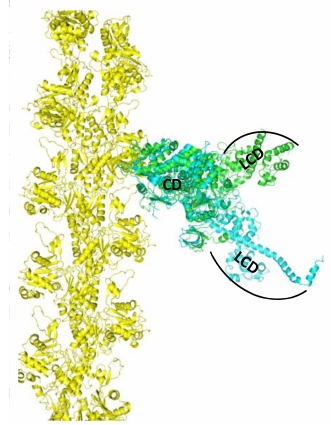
Figure 1. Model, based on superposition of catalytic domain (CD) of myosin crystal structures, for the strong-binding actin-myosin complex (actin yellow, myosin blue, light-chain domain (LCD) down, 2MYS [30]) and weak-binding complex (actin yellow, myosin green, LCD up, 1BR2 [31]). LCD (lever arm) rotation from up to down generates force in the actin-attached power